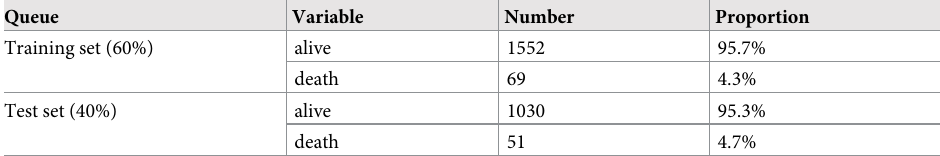
Table 3. Division of training queue and test